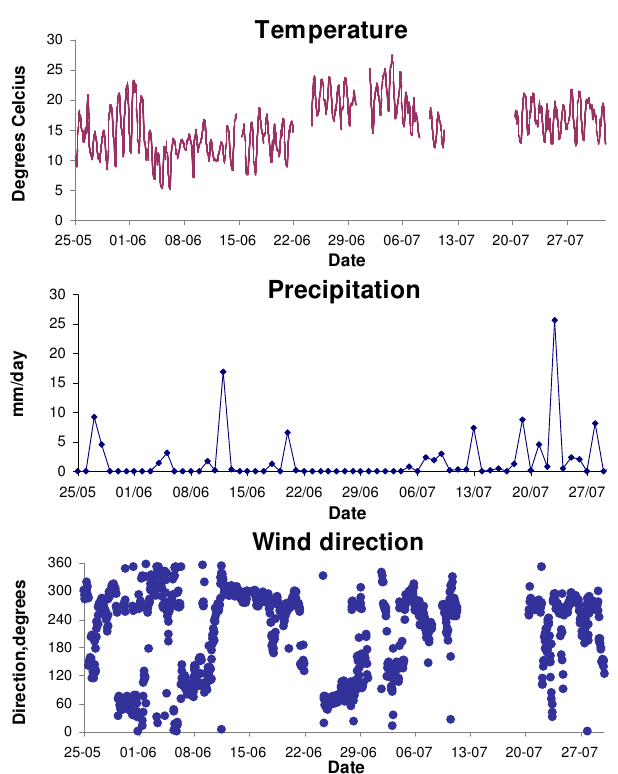
Fig. 6. Meteorological observations of temperature, precipitation and wind direction at the ENVS, AU monitoring site in central